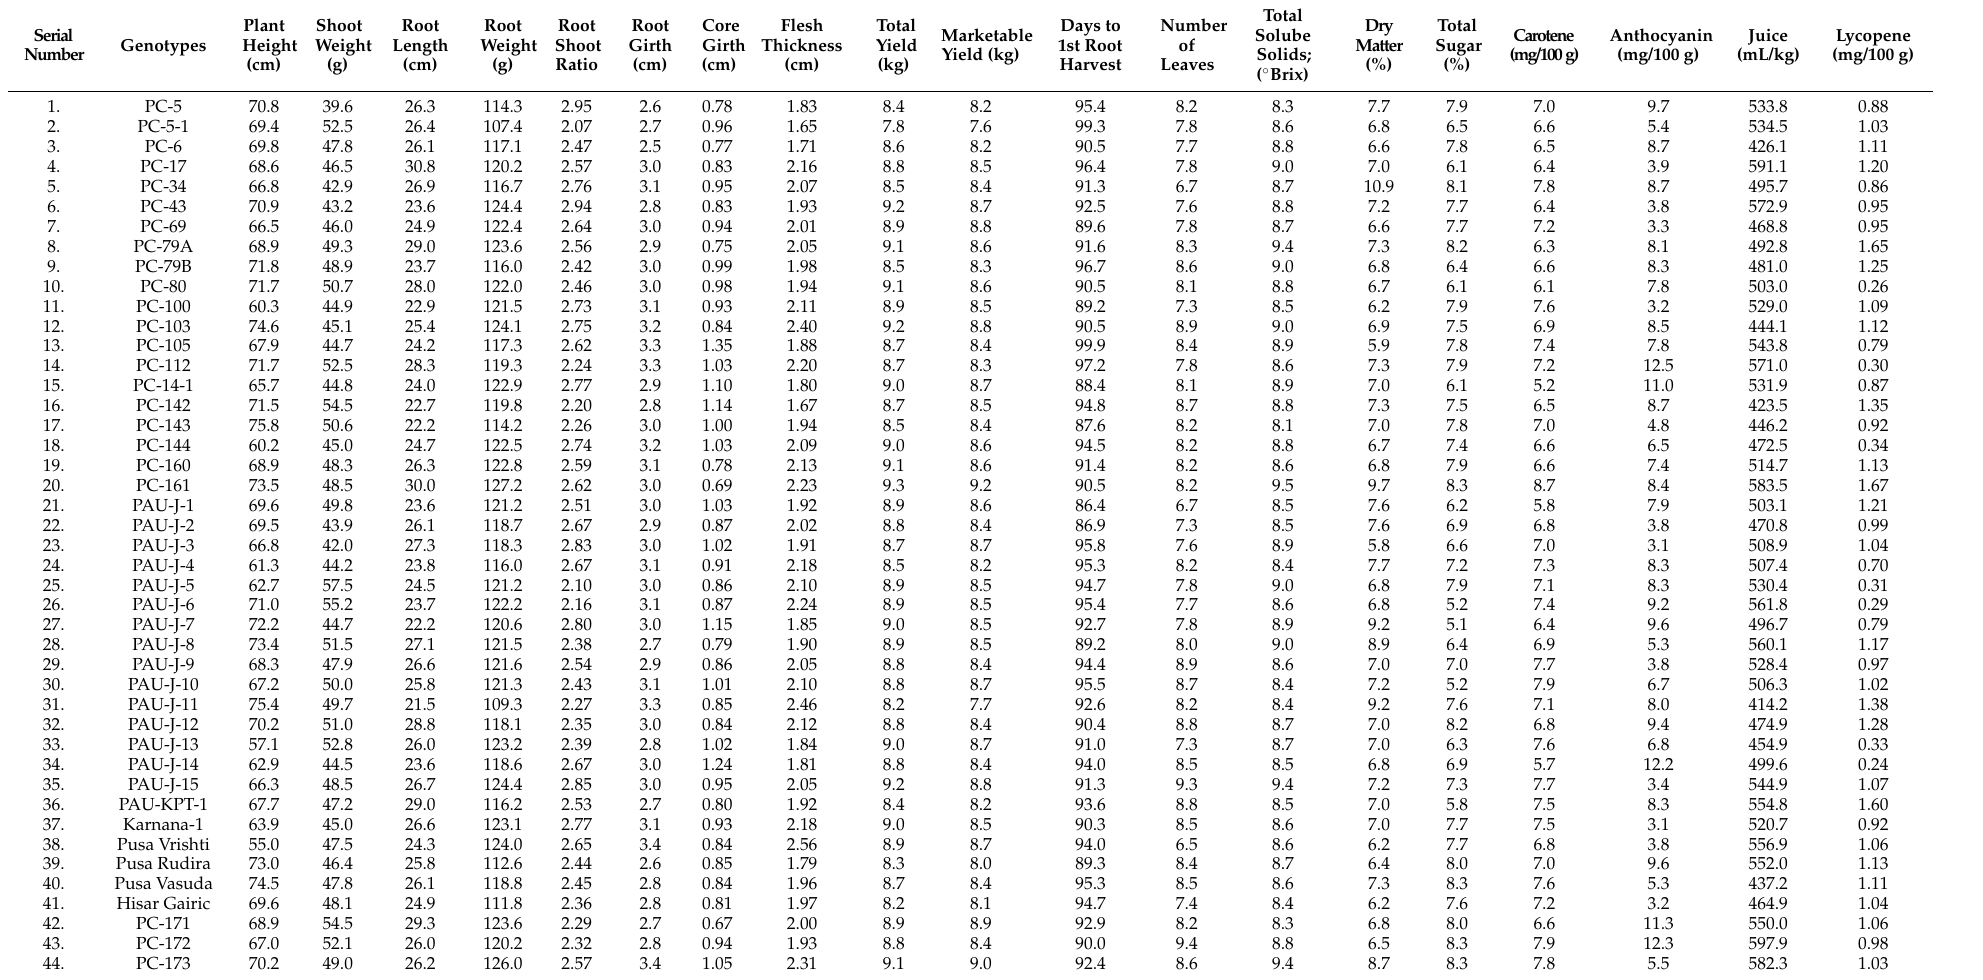
Table 2. Mean performance of all the 81 genotypes for different characters studied in